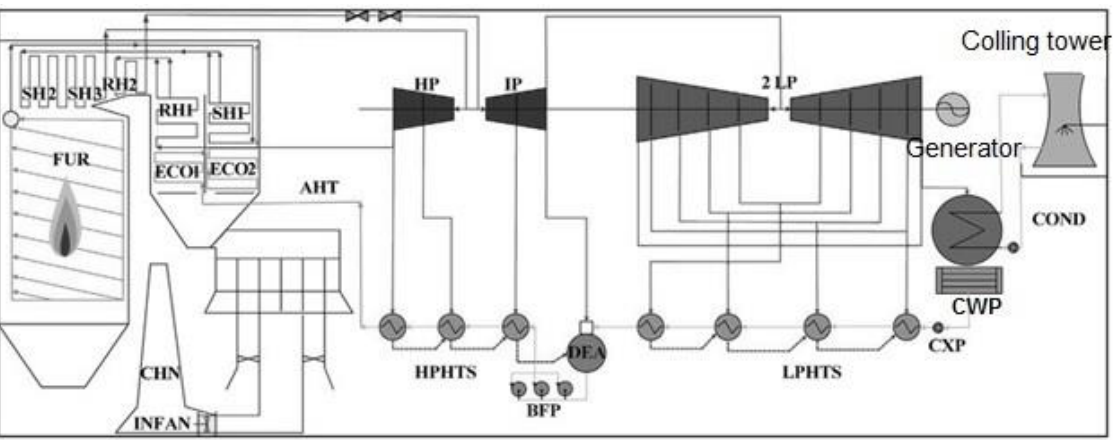
Figure 3. Supercritical thermal power plant line diagram.